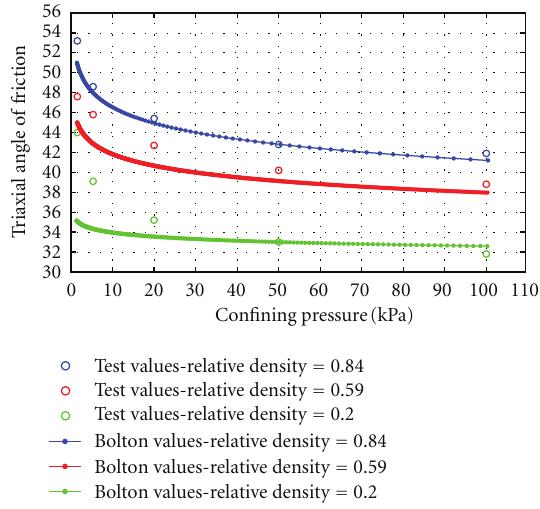
Figure 5: Friction angles for Esbjerg